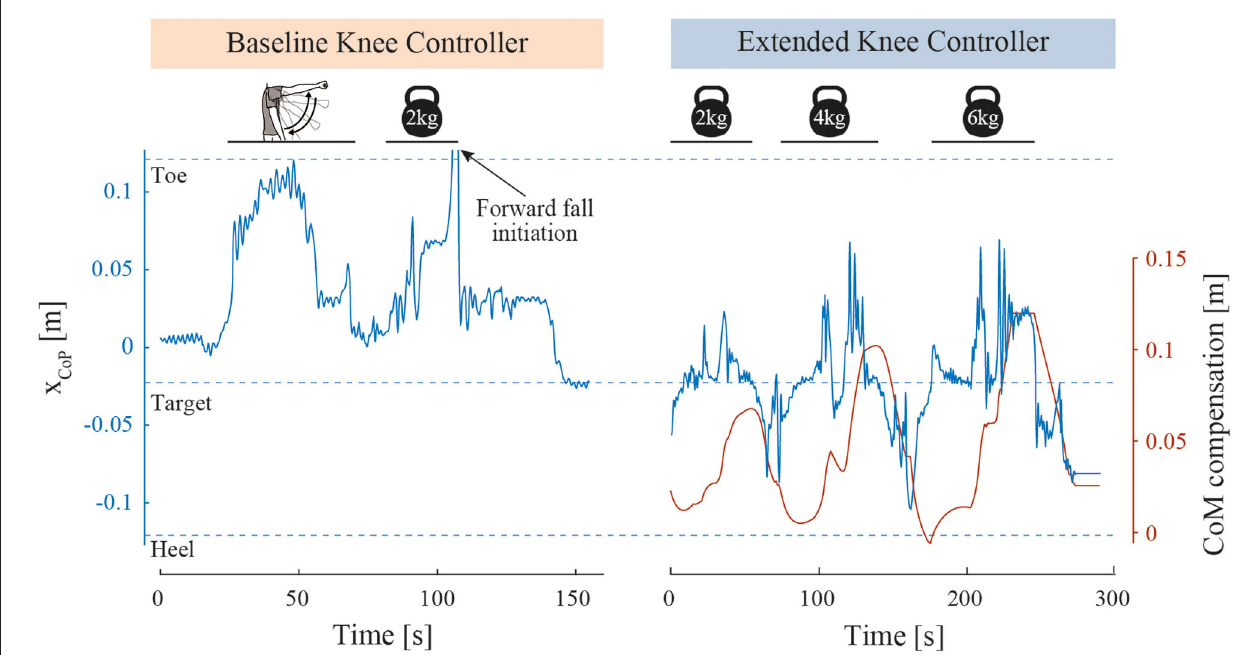
FIGURE 6 | Object lifting perturbation results. Foot contact point position (x CoP ) along the curved soles during object lifting perturbations. For BKC, the x CoP of one successful arm lift and one failed barbell lift is shown. When the toe tip has been reached, the pilot fell forward, was caught by the spotters and therefore the x CoP quickly returned close to zero. The barbell was then removed, and the system stabilization is highlighted by the x CoP returning to the target position. For EKC, the x CoP of 3 successful barbell lifts with increasing weights is represented, as well as the CoM compensation.